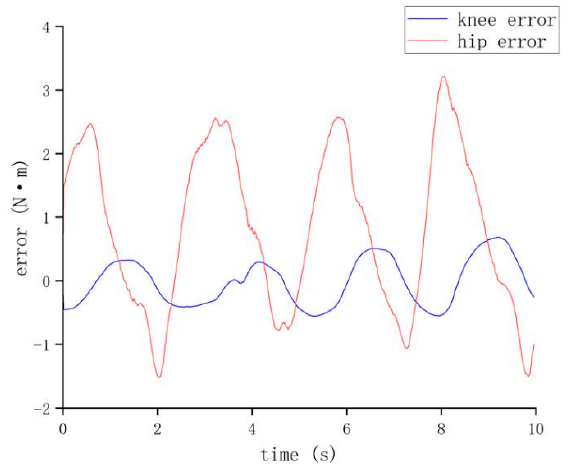
Figure 29. Error curve for moment-following test.